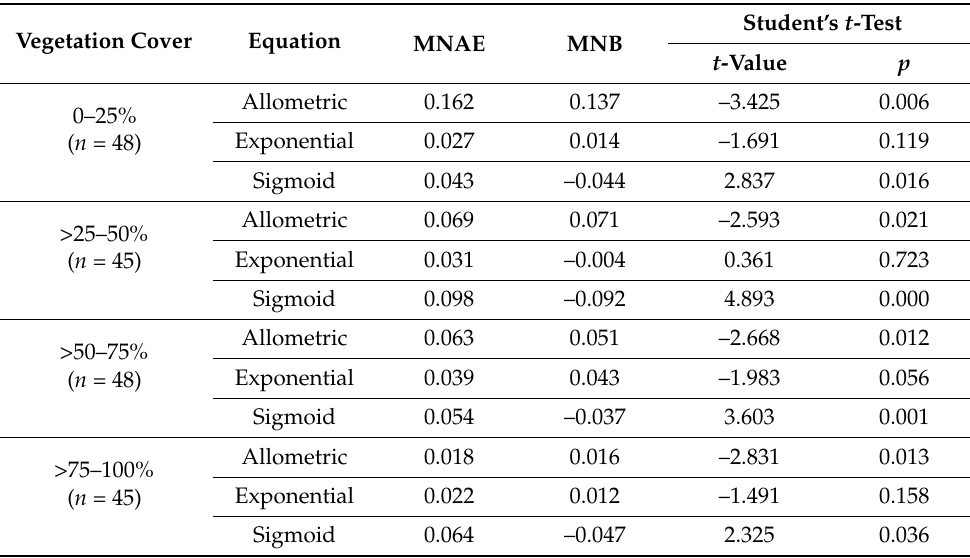
Table 6. Validation indices of cumulative soil organic carbon (SOC) stock (kg C/m 2 ) using three functions in ten sites of sabkhas with different vegetation covers along the southern Red Sea coast of Saudi